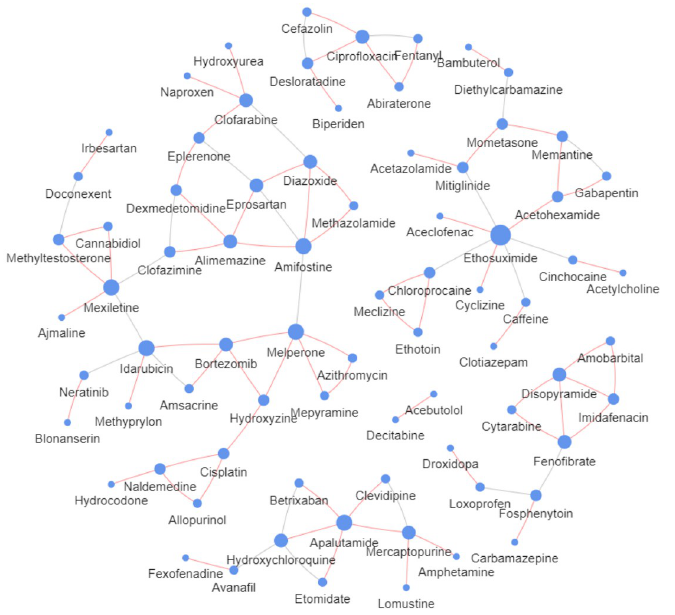
Fig 7. Top 100 pairs of DDI prediction